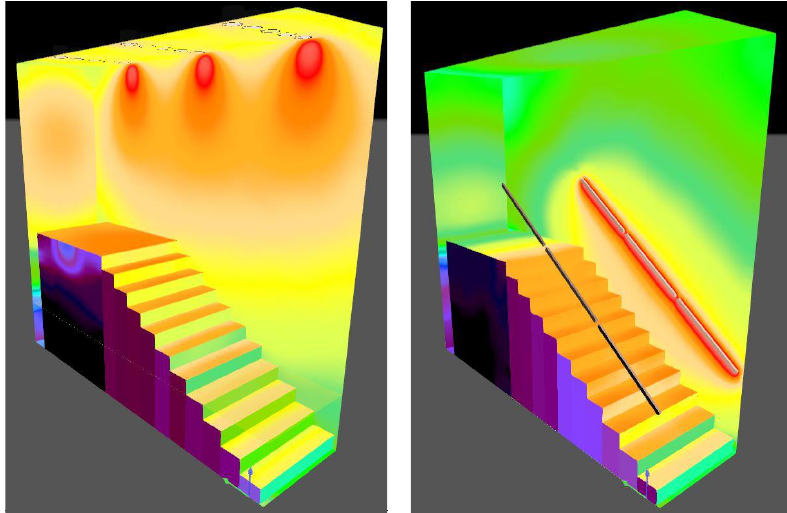
Figure 21. Simulation results (( Left ): Downlight, ( Right ): Line lighting).